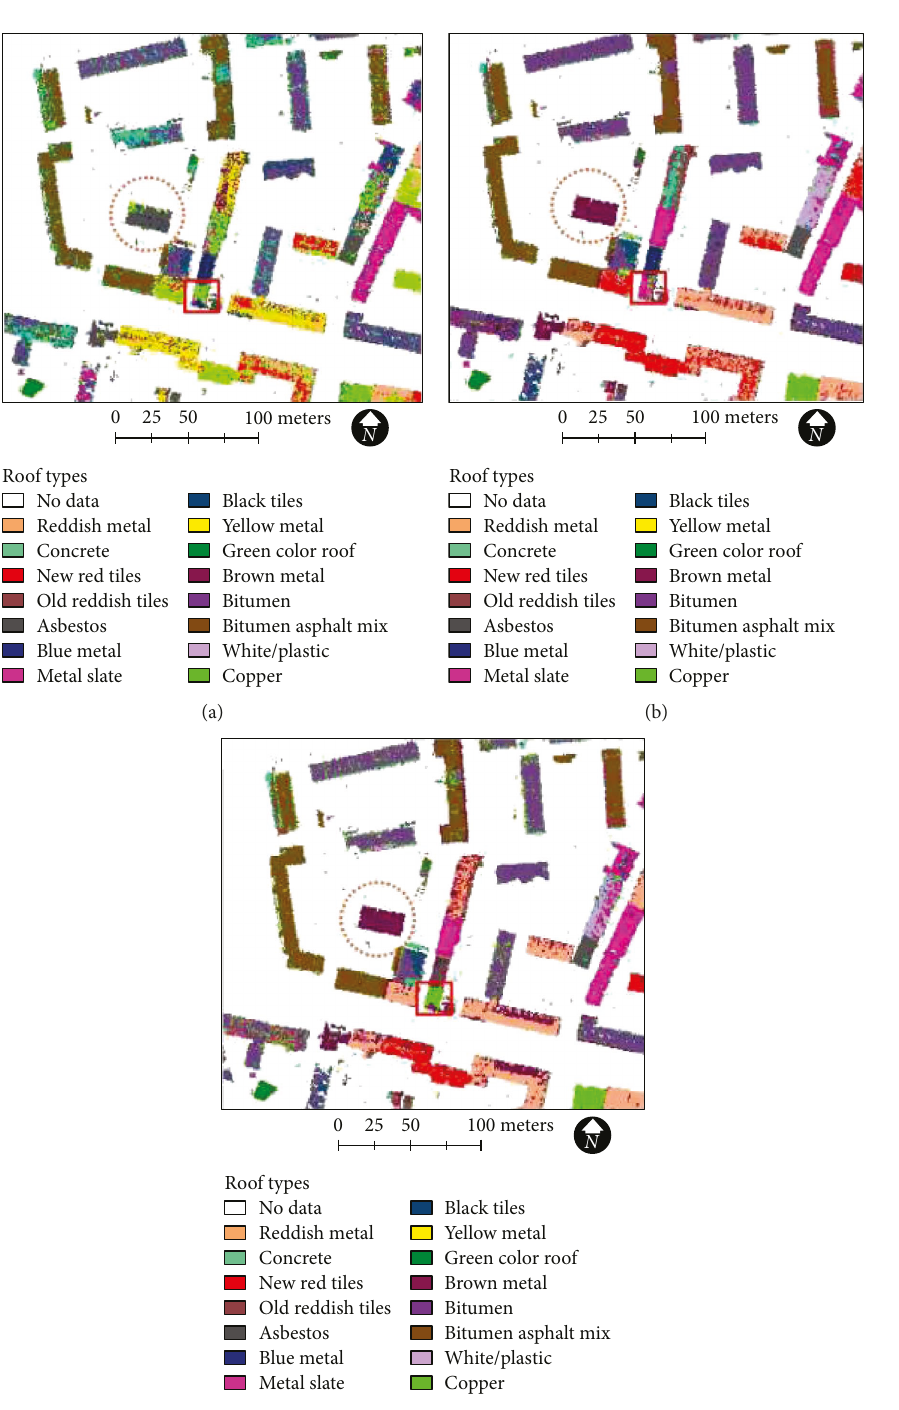
Figure 3: Classi fi cation results (best accuracies): (a) SAM using 303 spectral bands, (b) ANN using 76 PCA bands, and (c) SVM using 14 PCA-transformed bands. Dotted circle and square are used to compare the classi fi